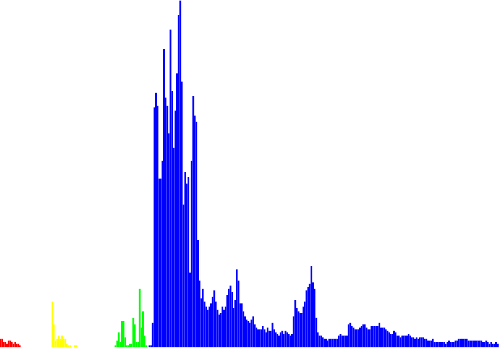
Figure 6: Distance histogram with color-encoded relevant